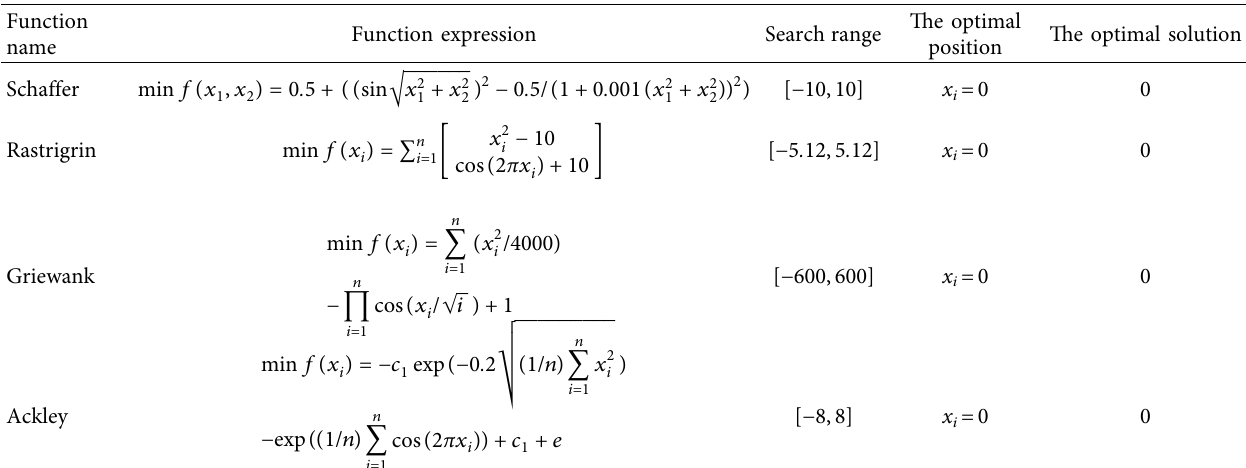
Figure 4: 3D graph of test functions: (a) Schwefel; (b) Rastrigin; (c) Griewank; (d) Ackley. Table 1: Standard test functions.